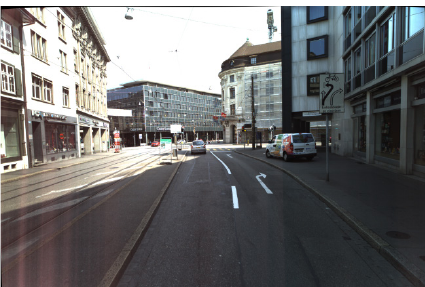
Figure 11. Base image from image sequence 3 for investigations in image